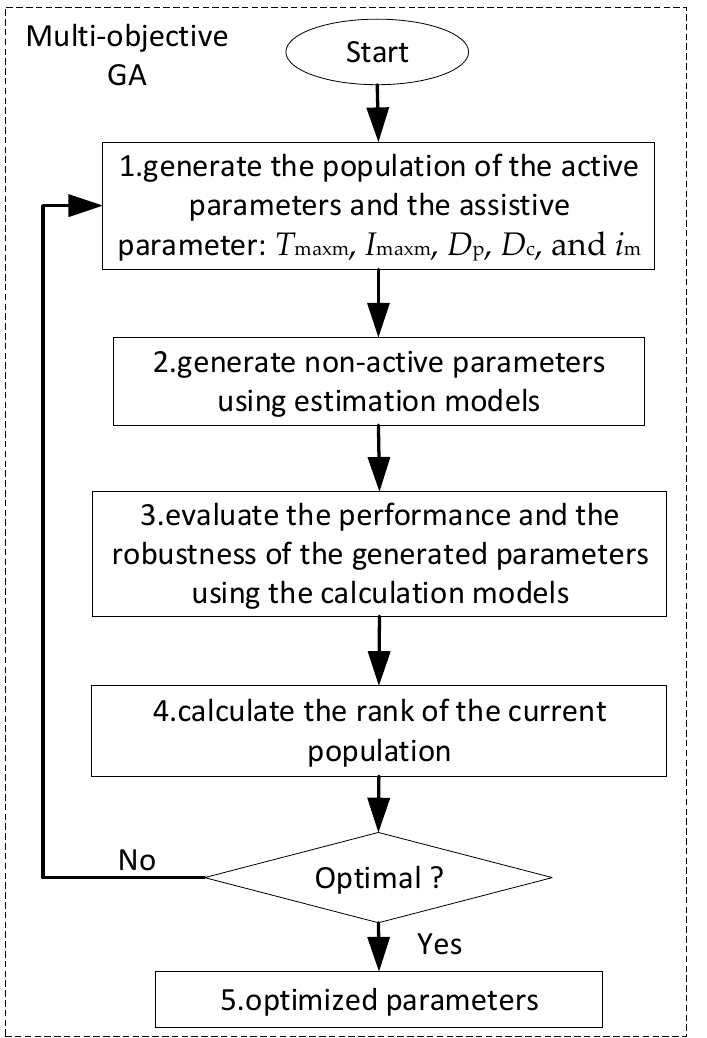
Figure 7. The suggested optimization design flowchart of the